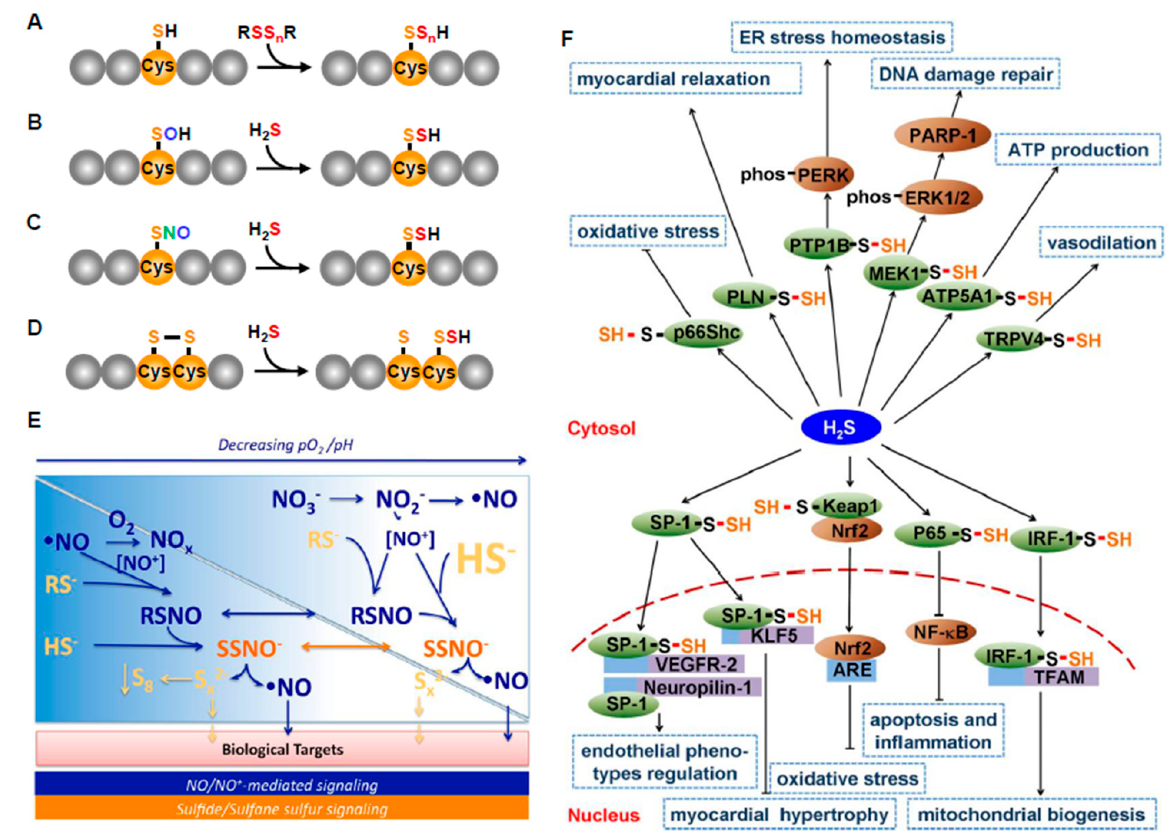
Figure 5. H 2 S and per- polysulfide signaling mechanisms. ( A – D ) Interactions of H 2 S or per- polysulfides (RSS n R, where R=H, Cys or GSH in various combinations and n = 1–4) with reactive protein Cys. ( E ) Sulfur and nitric oxide (NO)